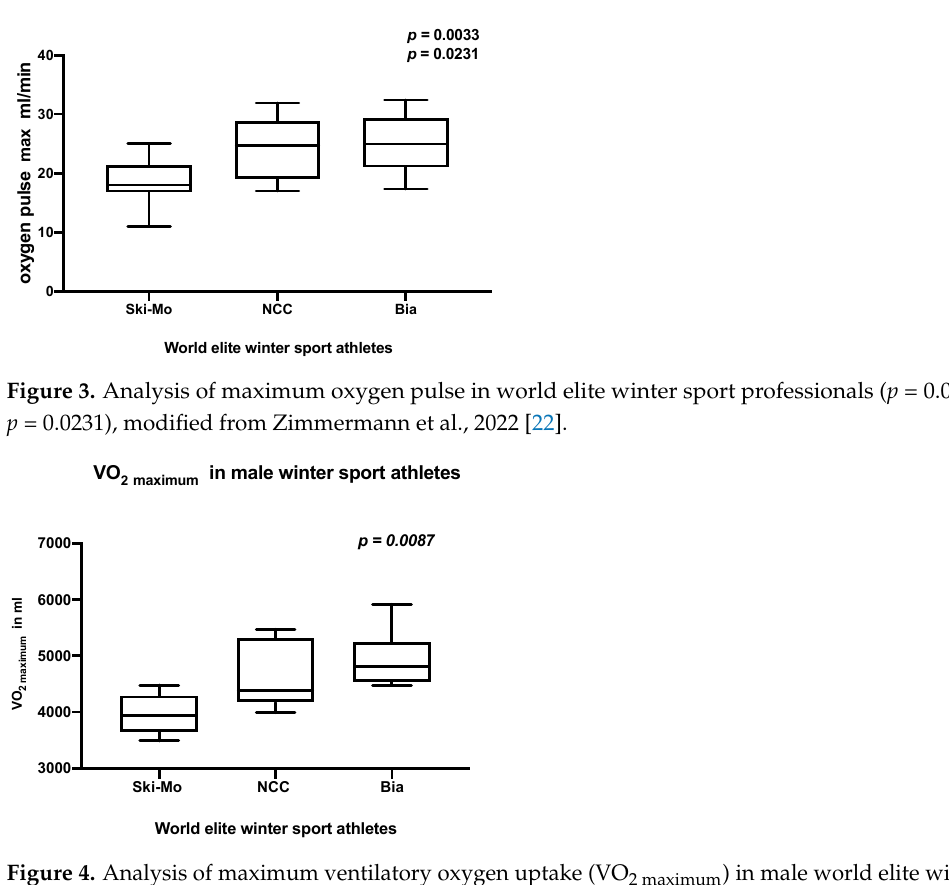
Figure 4. Analysis of maximum ventilatory oxygen uptake (VO 2 maximum) in male world elite win- ter sport professionals ( p = 0.0087).